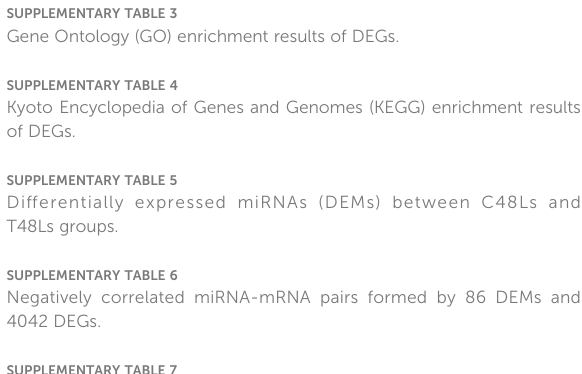
SUPPLEMENTARY TABLE 1 The sequence of primers used in this study. SUPPLEMENTARY TABLE 2 Differentially expressed genes (DEGs) between C48Lm and T48Lm groups. SUPPLEMENTARY TABLE 3 Gene Ontology (GO) enrichment results of DEGs. SUPPLEMENTARY TABLE 4 Kyoto Encyclopedia of Genes and Genomes (KEGG) enrichment results of DEGs. SUPPLEMENTARY TABLE 5 Differentially expressed miRNAs (DEMs) between C48Ls and T48Ls groups. SUPPLEMENTARY TABLE 6 Negatively correlated miRNA-mRNA pairs formed by 86 DEMs and 4042 DEGs. SUPPLEMENTARY TABLE 7 Gene Ontology (GO) enrichment results of the target genes. SUPPLEMENTARY TABLE 8 Kyoto Encyclopedia of Genes and Genomes (KEGG) enrichment results of the target genes.